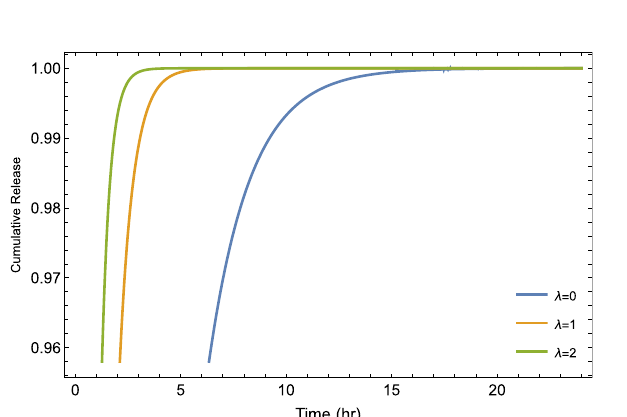
Figure 8. Plot of cumulative drug release given by Eq. (13) for different values of fractional orders α at (cid:31) = 0 and R = 0.5 .